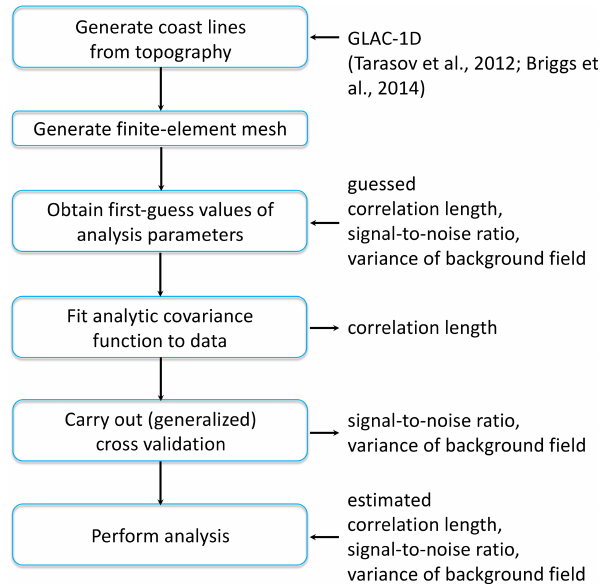
Figure 3. General workflow of the DIVA (Data-Interpolating Vari- ational Analysis) method (Troupin et al.,